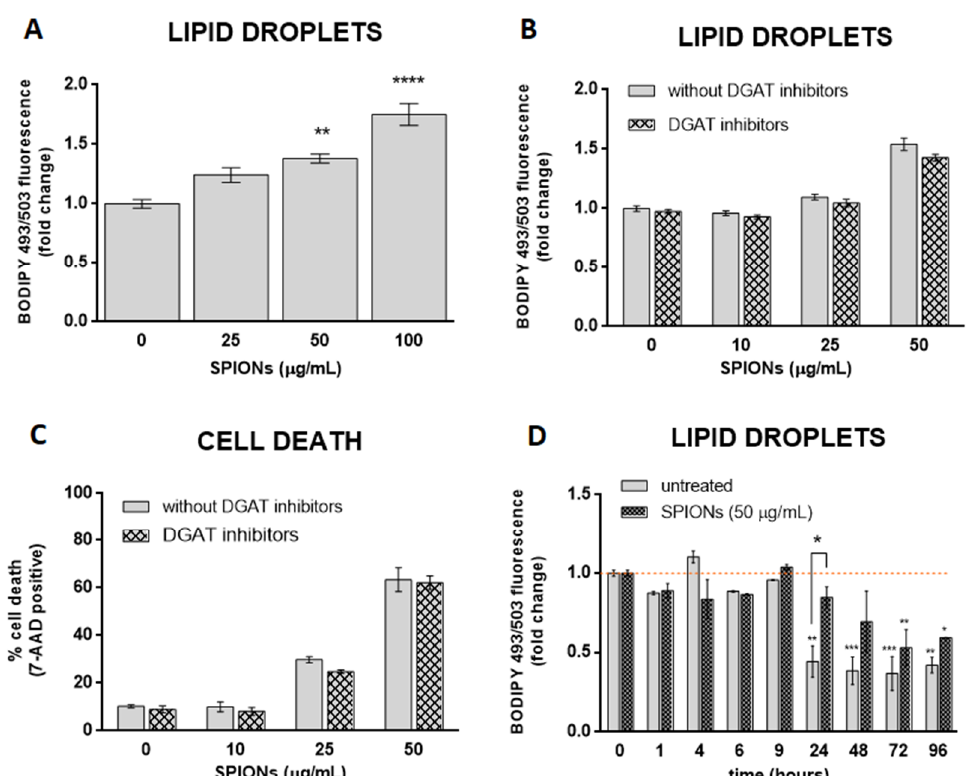
Figure 3. Silica-coated SPIONs-induced lipid droplet (LD) accumulation is not dependent on diacylglycerol acyltransferase (DGAT)-mediated LD biogenesis. ( A ) HUVEC cells were treated with silica-coated SPIONs (25, 50, and 100 µg/mL) for 24 h and LDs were quantified by flow cytometry using BODIPY 493/503 staining. ( B , C ) HUVEC cells were treated with combination of DGAT1 and DGAT2 inhibitors (5 µM T863 and 5 µM PF-06424439) and silica-coated SPIONs for 24 h. LDs and cell death were quantified by flow cytometry using BODIPY 493/503 ( B ) and 7-AAD staining ( C ), respectively. ( D ) HUVEC cells were treated with silica-coated SPIONs and LD levels were quantified in different time points (1–96 h) by flow cytometry using BODIPY 493/503 staining. Values on the graphs are means ± SEM of at least three independent experiments; statistically significant differences in mean values are indicated (*, p < 0.05; **, p < 0.01; ***, p < 0.001; ****, p < 0.0001; one-way ANOVA with Tukey post hoc test).